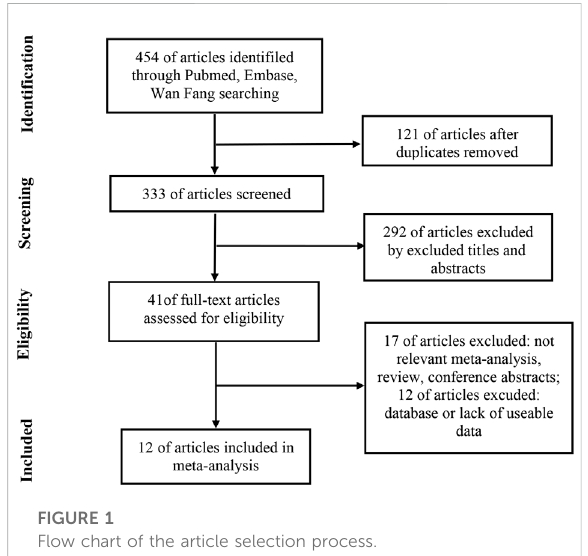
FIGURE 1 Flow chart of the article selection